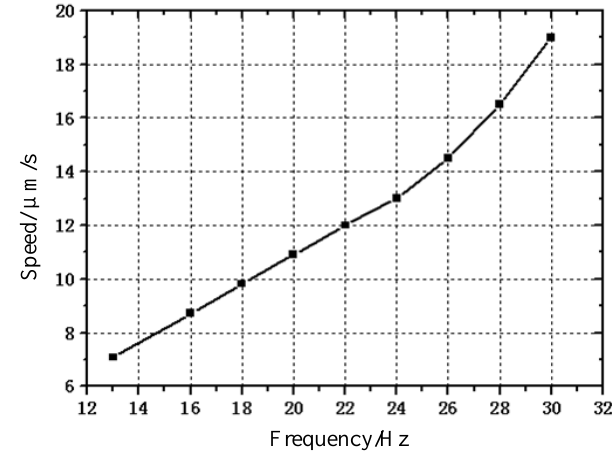
Figure 13. Moving speed versus driving frequency.